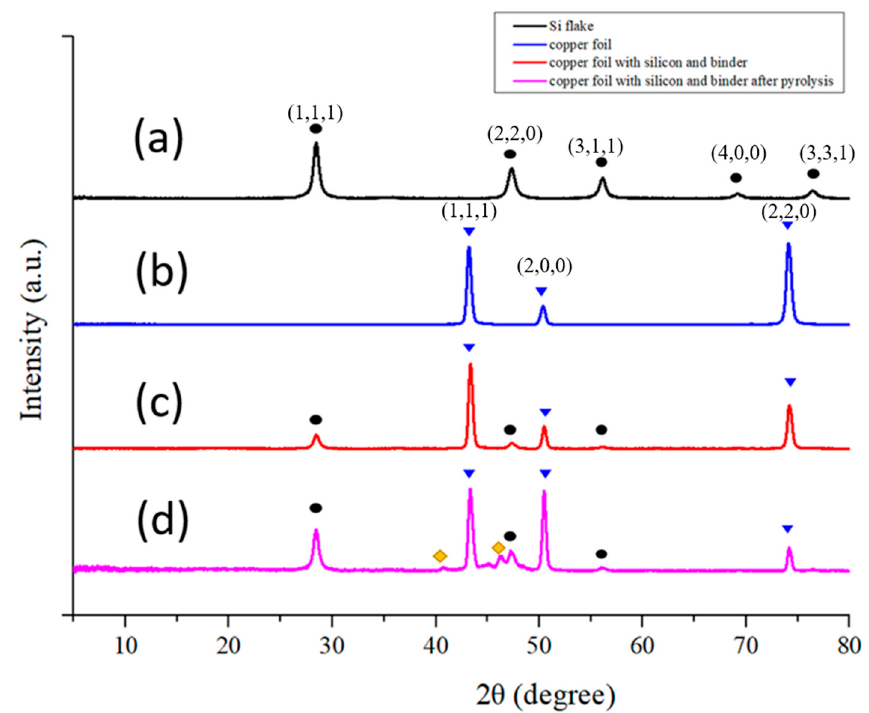
Figure 7. XRD Patterns of ( a ) Si flake, ( b ) Copper foil, ( c ) Si based anode without conductivity enhancement additive, and ( d ) Pyrolytic Si based anode without conductivity enhancement additive. Peaks marked by the same symbols belong to the same crystal facets. Peaks which are marked in yellow are